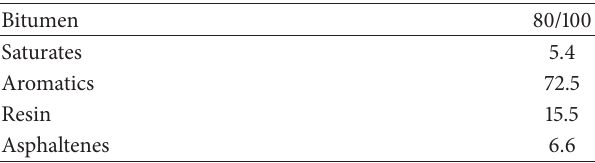
Table 2: Chemical composition of bitumen (%)(Standard IP 469).